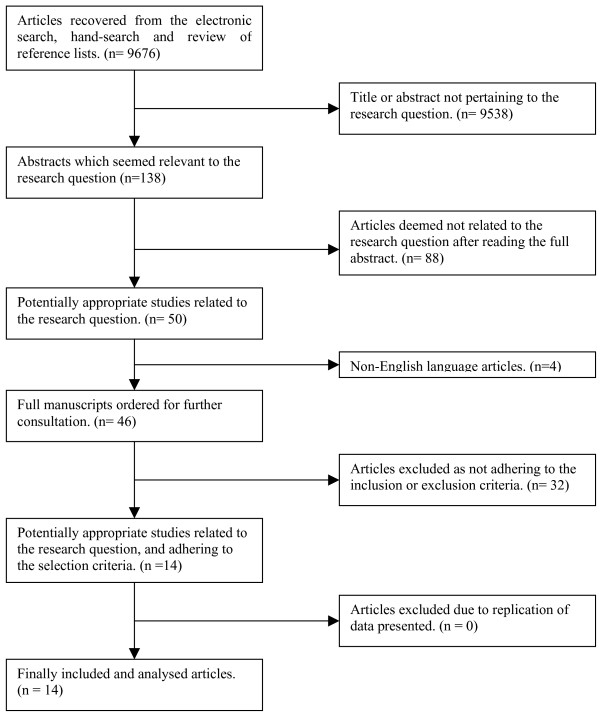
QUORUM flow chart.